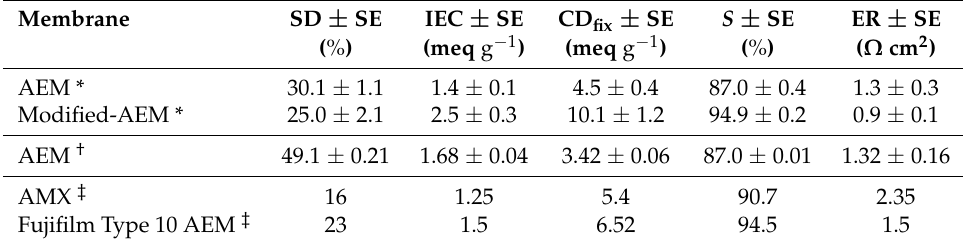
Table 2. Swelling degree (SD), Ion Exchange Capacity (IEC), Fixed charge density (CD fix ), Permselectivity ( S ), and Electrical resistance (ER) with standard error (SE, n = 3) of the synthesized AEM before and after modification. We also include reference values found in the literature [39], and values for two commercially available AEMs, an AMX and a Fujifilm Type 10 AEM [3,71]. Membrane SD ± SE IEC ±